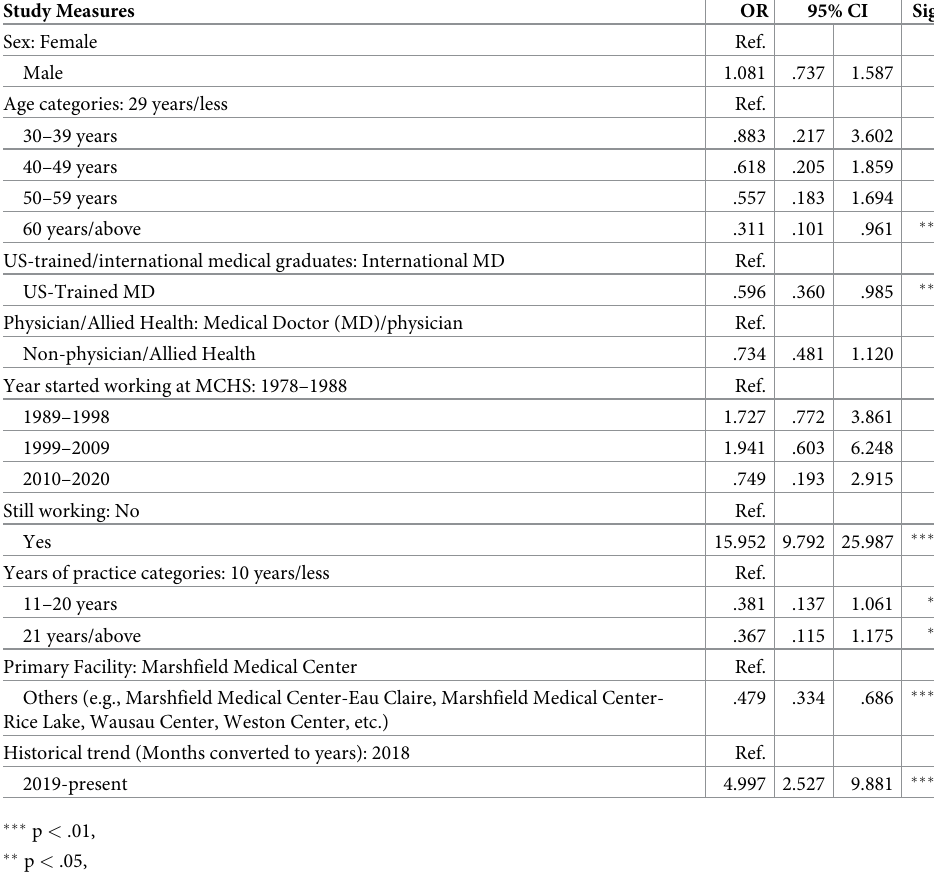
Table 3. User and institutional factors influencing MCHS provider voice recognition uptake (study outcome), adjusted,